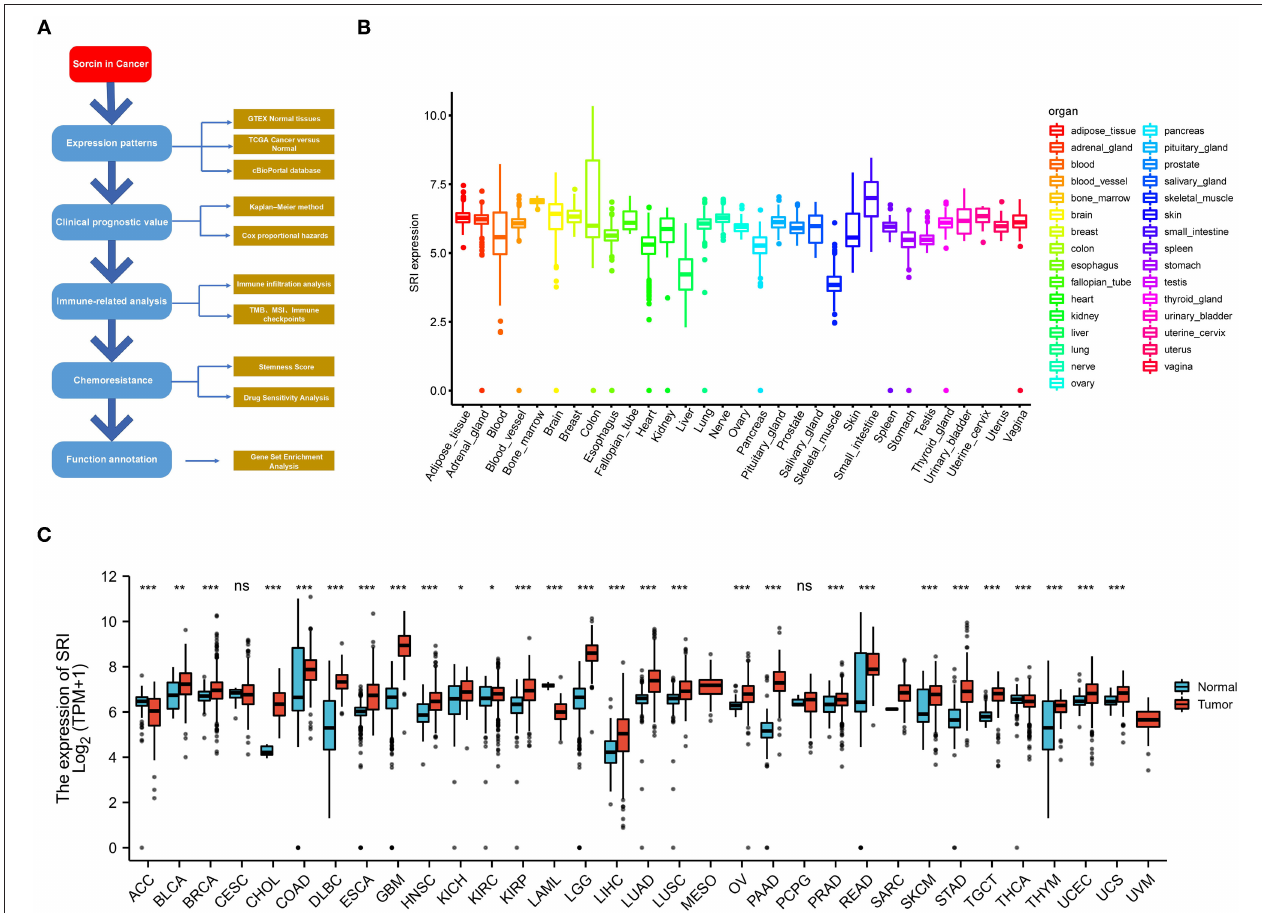
FIGURE 1 | Differential expression of SRI. (A) Outline of the workflow for this research. (B) The SRI expression in normal tissues from Genotype Tissue-Expression (GTEX) data. (C) Differential SRI mRNA expression between 33 The Cancer Genome Atlas (TCGA) cancers and GTEX normal tissues. The red color column represents the cancer samples and the blue color column represents the normal samples. ns, P ≥ 0.05; *, P < 0.05; **, P < 0.01; and ***, P <